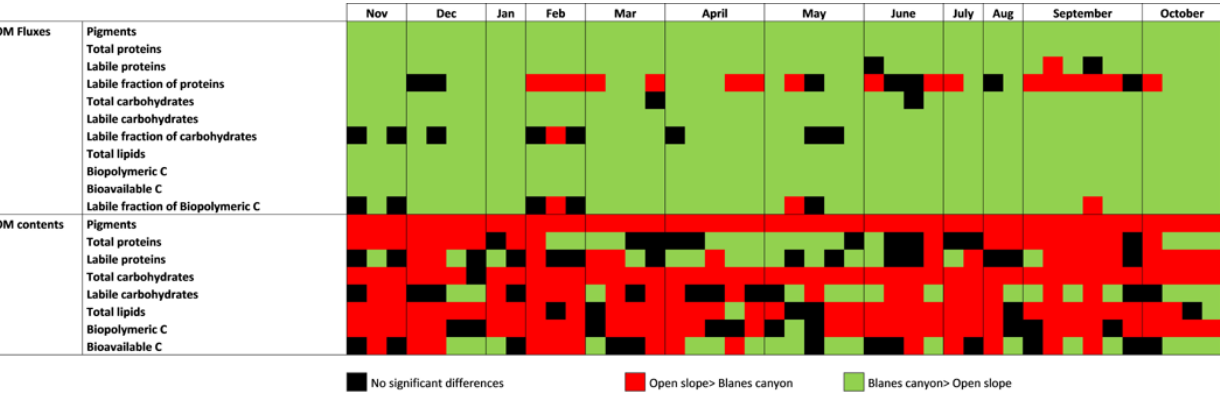
Fig. 6. Pairwise test of organic matter fluxes and contents between the two morphologies at each sampling time/period and among sampling periods/times, separately for each seabed